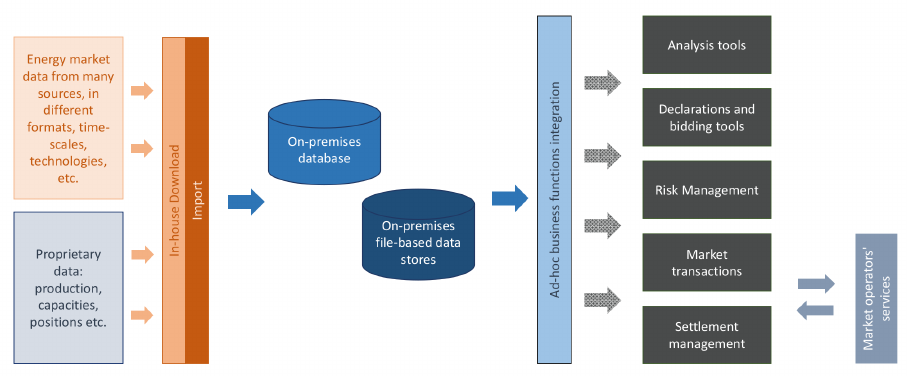
Figure 4. Typical Energy Trading